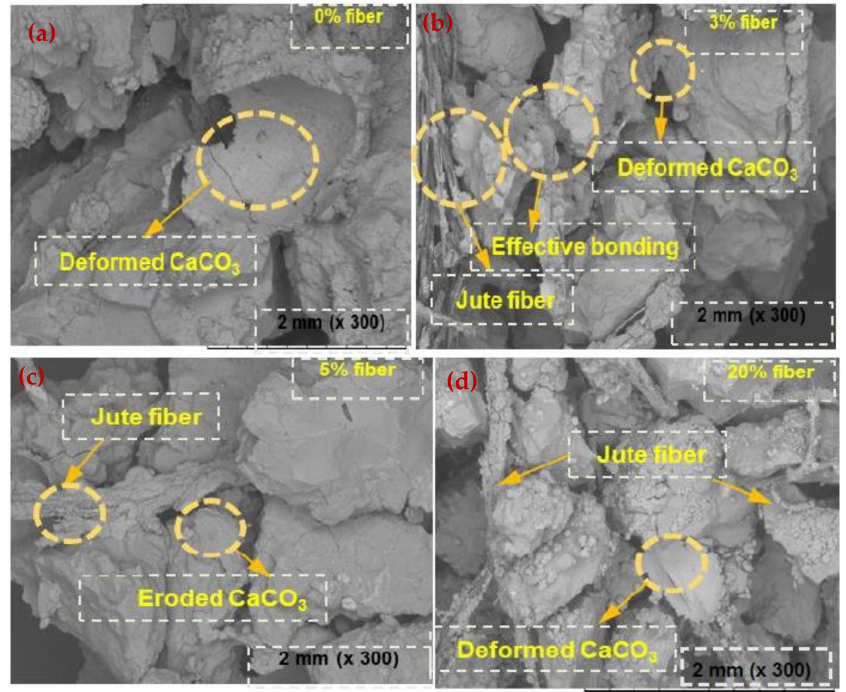
Figure 9. SEM images (ASW) of the specimens after exposure to WD cycles. ( a ) 0% fiber; ( b ) 3% fiber; ( c ) 5% fiber and ( d ) 20%